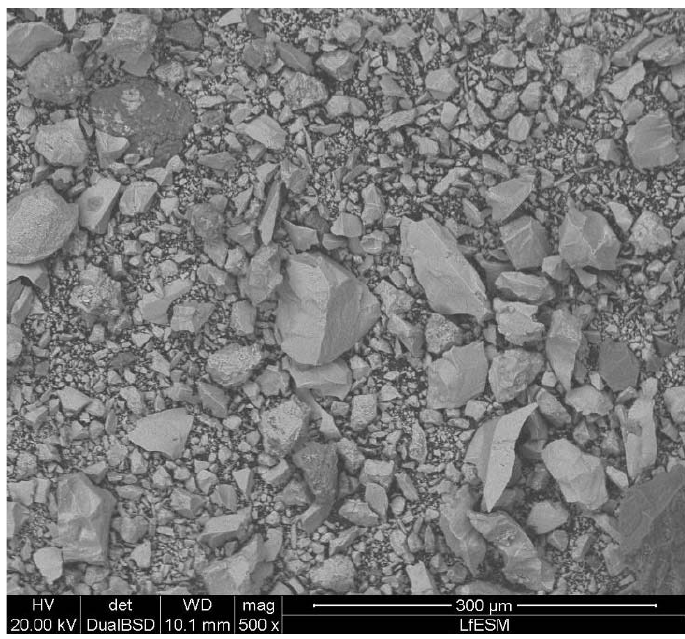
Figure 2. Scanning electron microscopy picture of sample E.